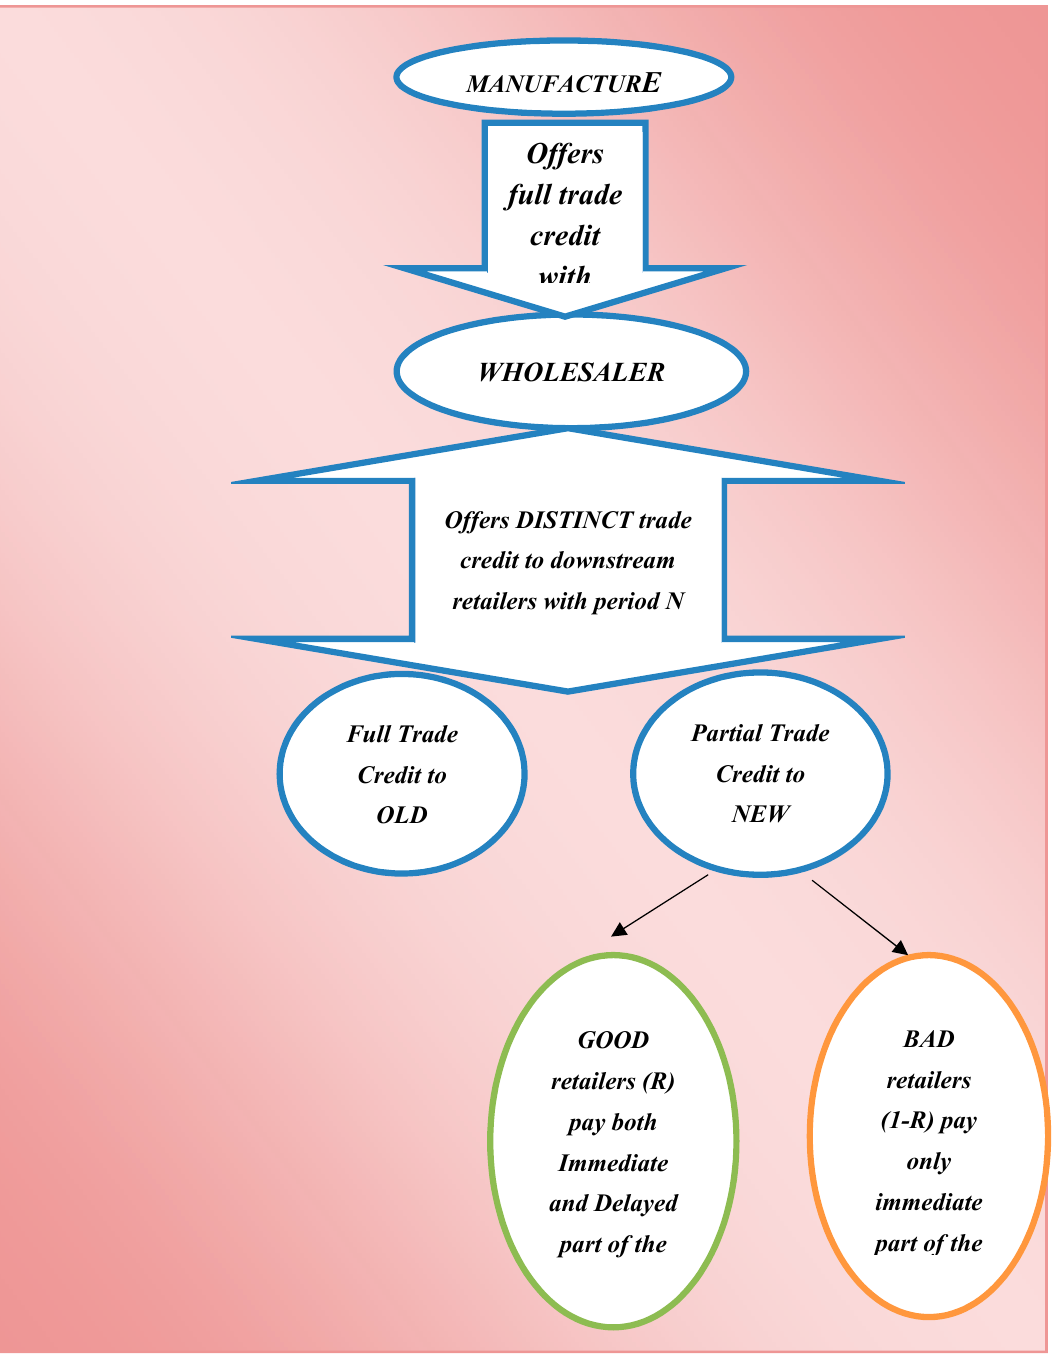
Figure 1. Sequence of permissible delay in the inventory Figure 1 . Sequence of permissible delay in the inventory cycle.